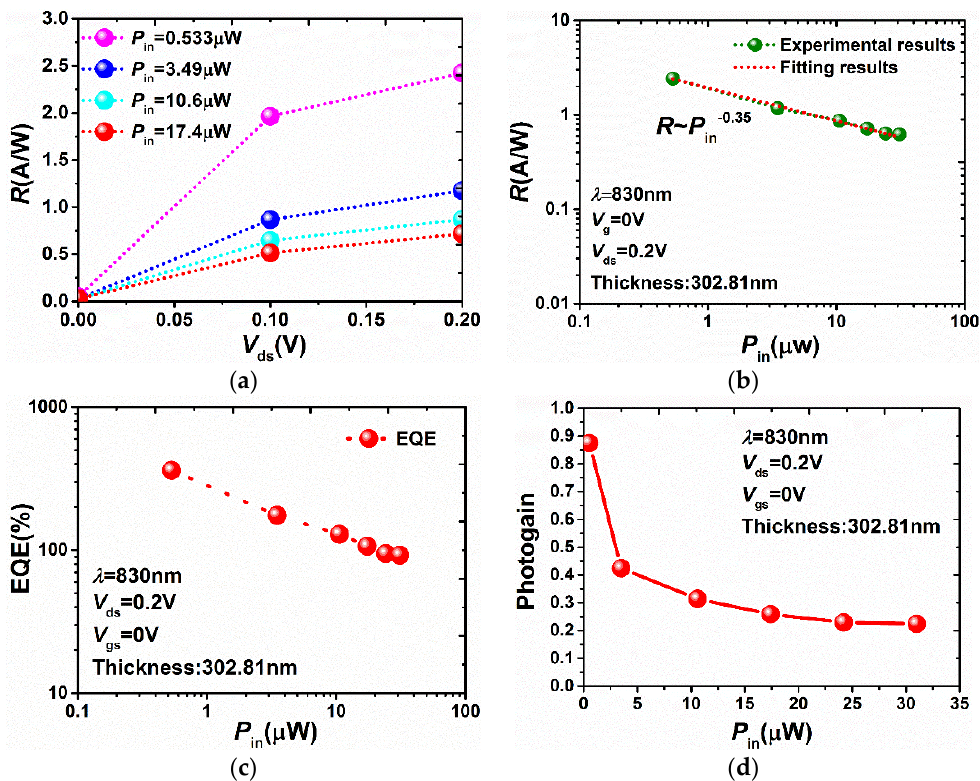
Figure 4. ( a ) R as a function of applied source ‐ drain voltage under different optical powers. ( b ) R as a function of excitation power P in incident on the device area. ( c ) EQE as a function of excitation power P in . ( d ) The photogain with a series of incident power.